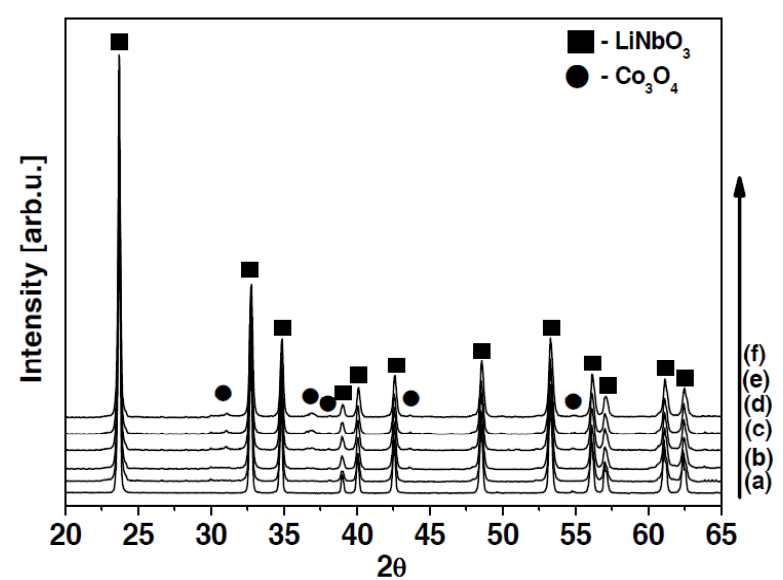
Figure 2. XRD patterns of LiNbO